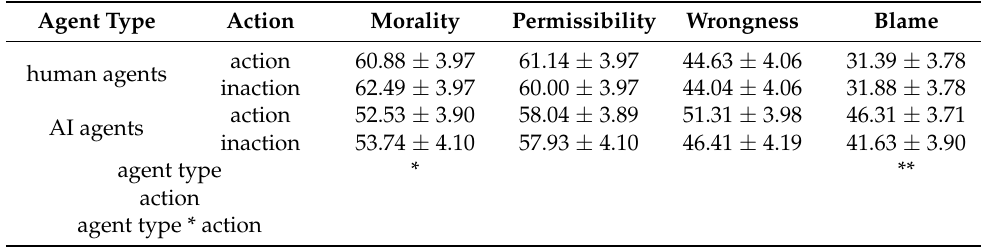
Table 1. Rates of morality, permissibility, wrongness, and blame on human and AI agents in Experiment 1. Agent